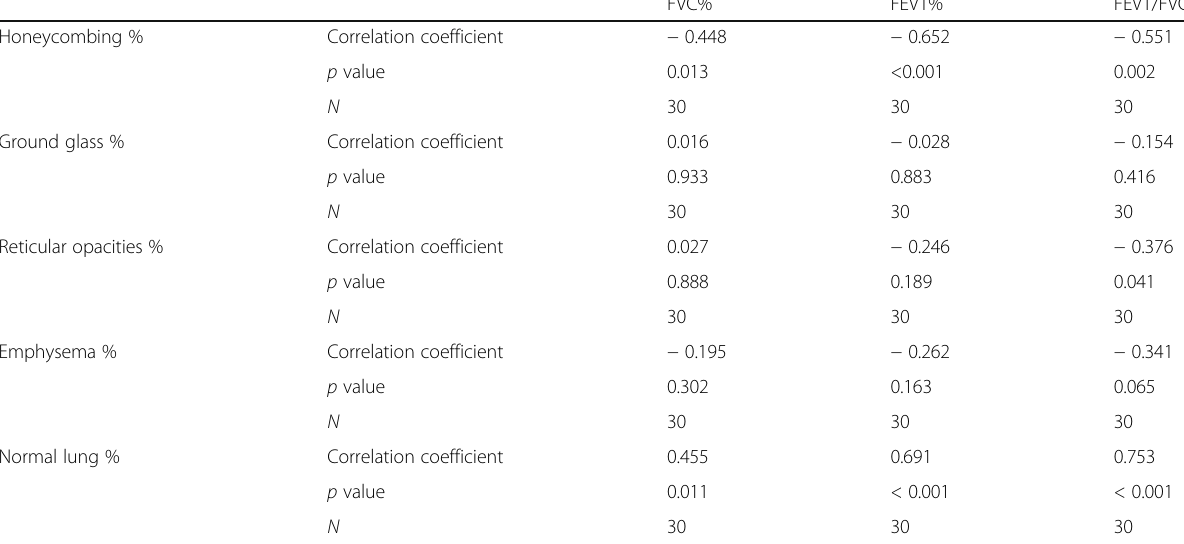
Table 6 Correlation between different pulmonary affection (honeycombing, ground glass, reticulation, emphysema, normal lung) using quantitative CT analysis and PFTs FVC% FEV1% FEV1/FVC% Honeycombing % Correlation coefficient − 0.448